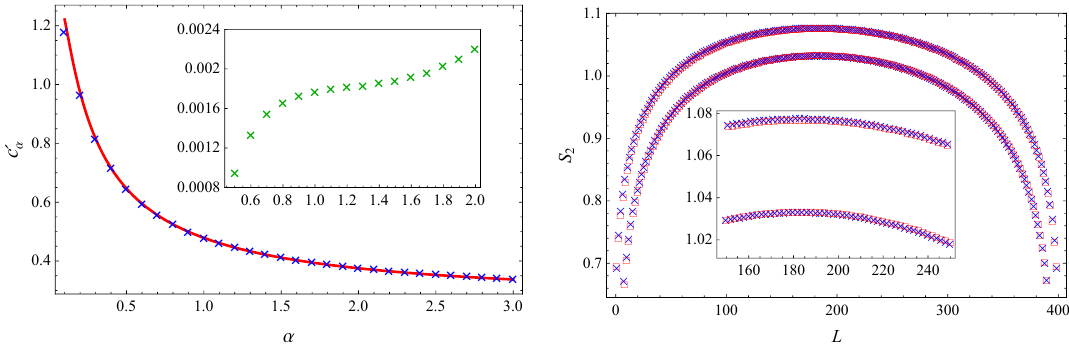
Figure 2 . Left: constant term c 0 in the asymptotic approximation (4.14)–(4.15) to the Rényi α entanglement entropy S α of the sextic chain with a = 10 − 2 and N = 400 spins for α = i/ 10 and 1 6 i 6 30 (blue crosses) compared to the corresponding constant c 0 for the homogeneous XX chain α in eq. (4.4) (solid red line). The inset shows the difference between c 0 and its counterpart (4.4) for α the homogeneous chain in the range 1 / 2 6 α 6 2 at intervals of 1 / 10 . Right: Rényi entanglement entropy S 2 for the sextic chain with a = 10 − 2 and N = 400 spins at half filling and zero magnetic field (blue crosses) compared to its asymptotic approximation (4.14) (red squares). The inset shows a blow up of the range 150 6 L 6 250 in the latter